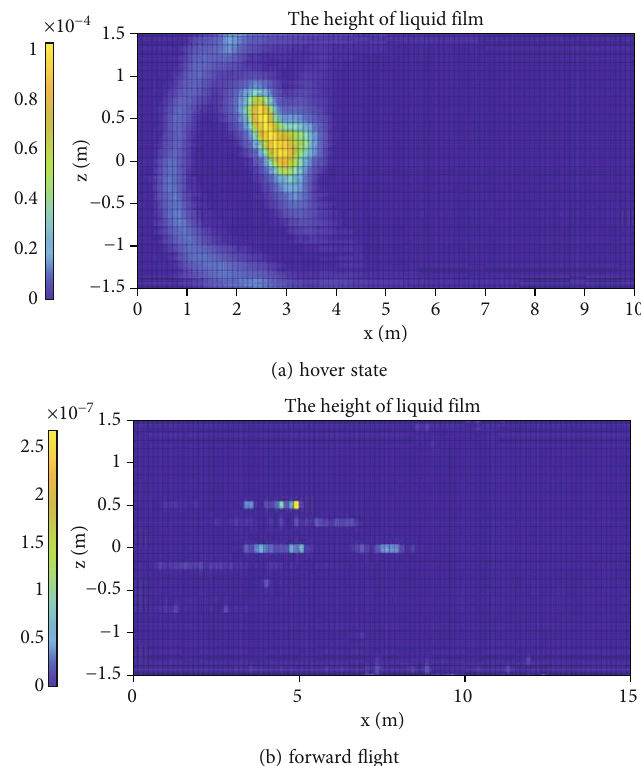
Figure 9: The height of deposited liquid fi lm on the ground when velocity is 2